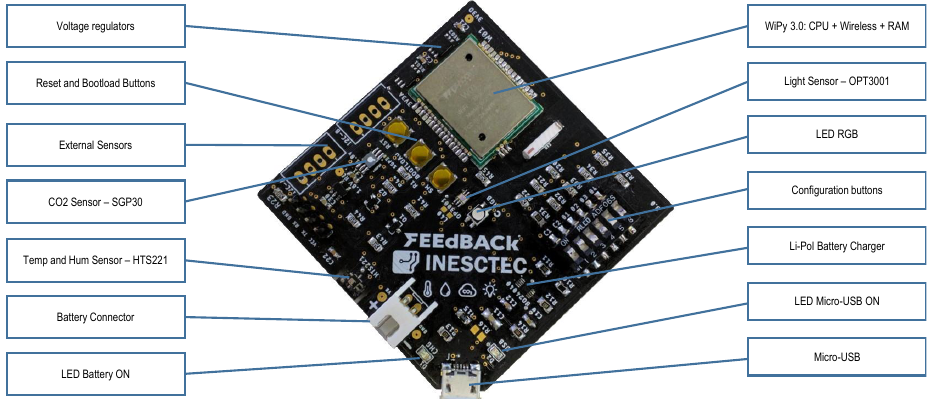
Figure 5. Multisensor developed for